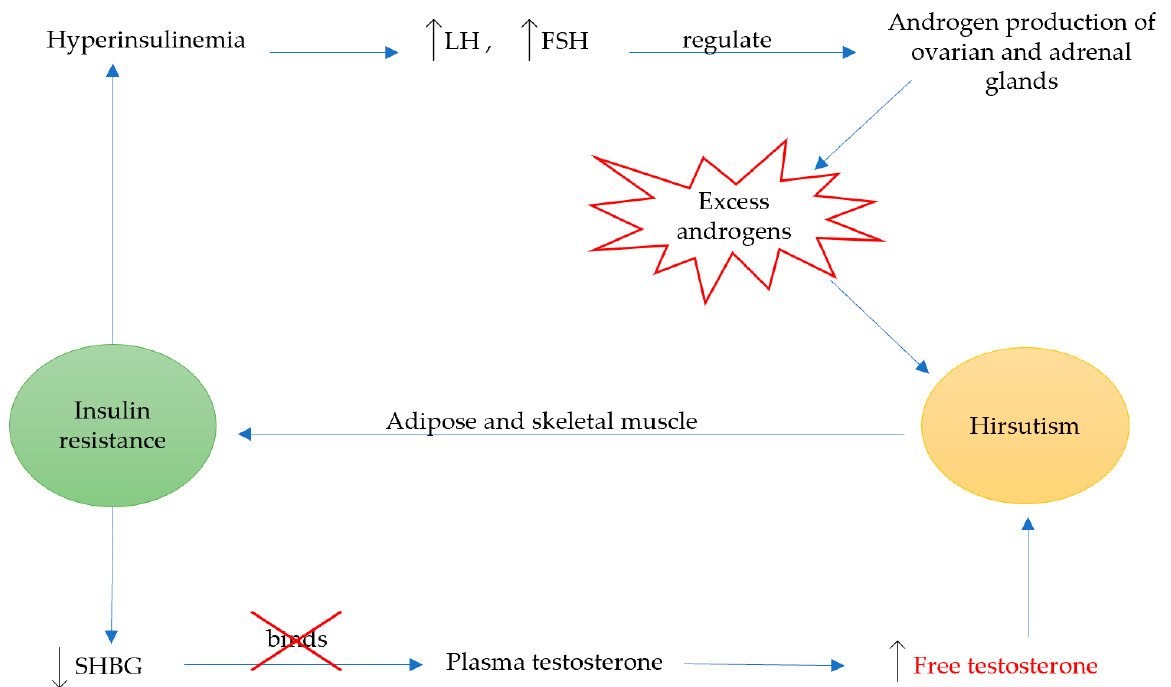
Figure 3. The relationship between insulin resistance and hirsutism. Hyperinsulinemia is caused when insulin resistance is left unmanaged, causing an increase in LH and FSH, which regulate the production of ovarian and adrenal androgens. This increase results in excess androgens, and eventually hirsutism. Moreover, insulin resistance reduces SHBG, which leaves plasma testosterone unbound leading to increased free testosterone and hirsutism. Chronic androgen exposure leads to adipose and skeletal muscle insulin resistance. The graph above presents the circular relationship between the two conditions, leading to a vicious cycle of effects.